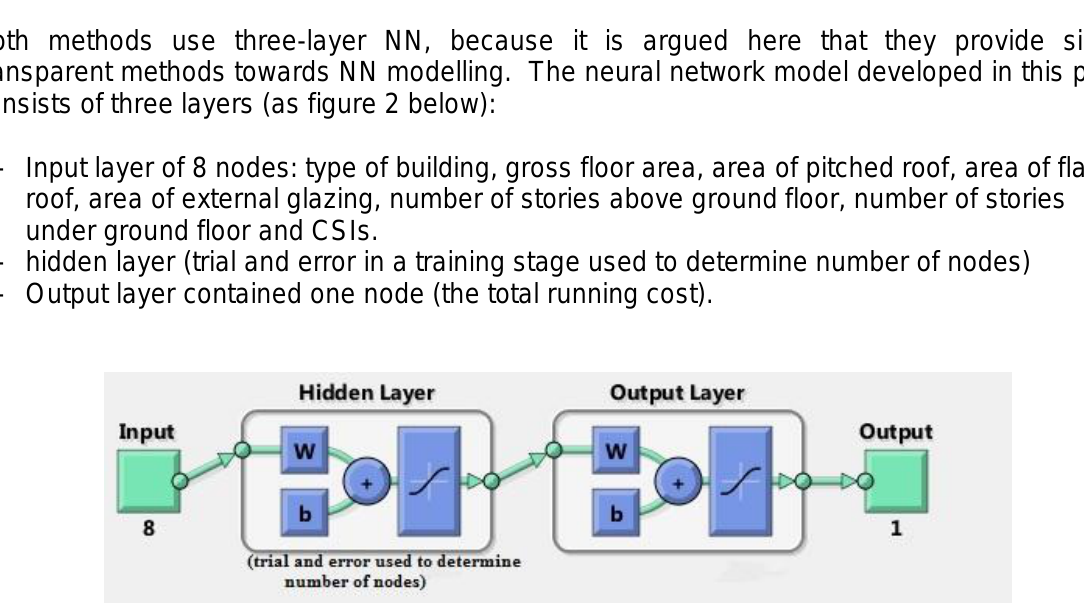
Figure 2 neural network structure with three